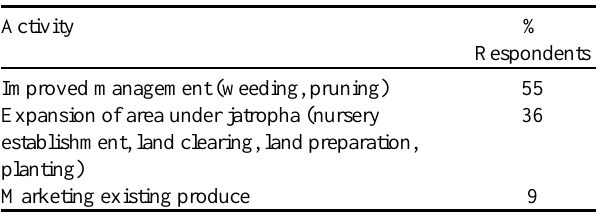
Table 3 . Labor allocations among respondents